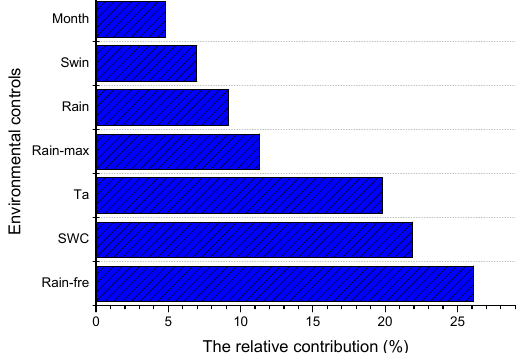
Figure 3. The relative contribution of the main environmental controls to the variability in the daily shallow soil seepage probability (abbreviations: Month is categorical variable for the month period of soil seepage events, Swin is solar radiation, Rain is the rainfall amount, Rain–max is the maximum half–hour rainfall amount, Ta is the air temperature, SWC is the soil water content, and Rain–fre is the rainfall frequency).